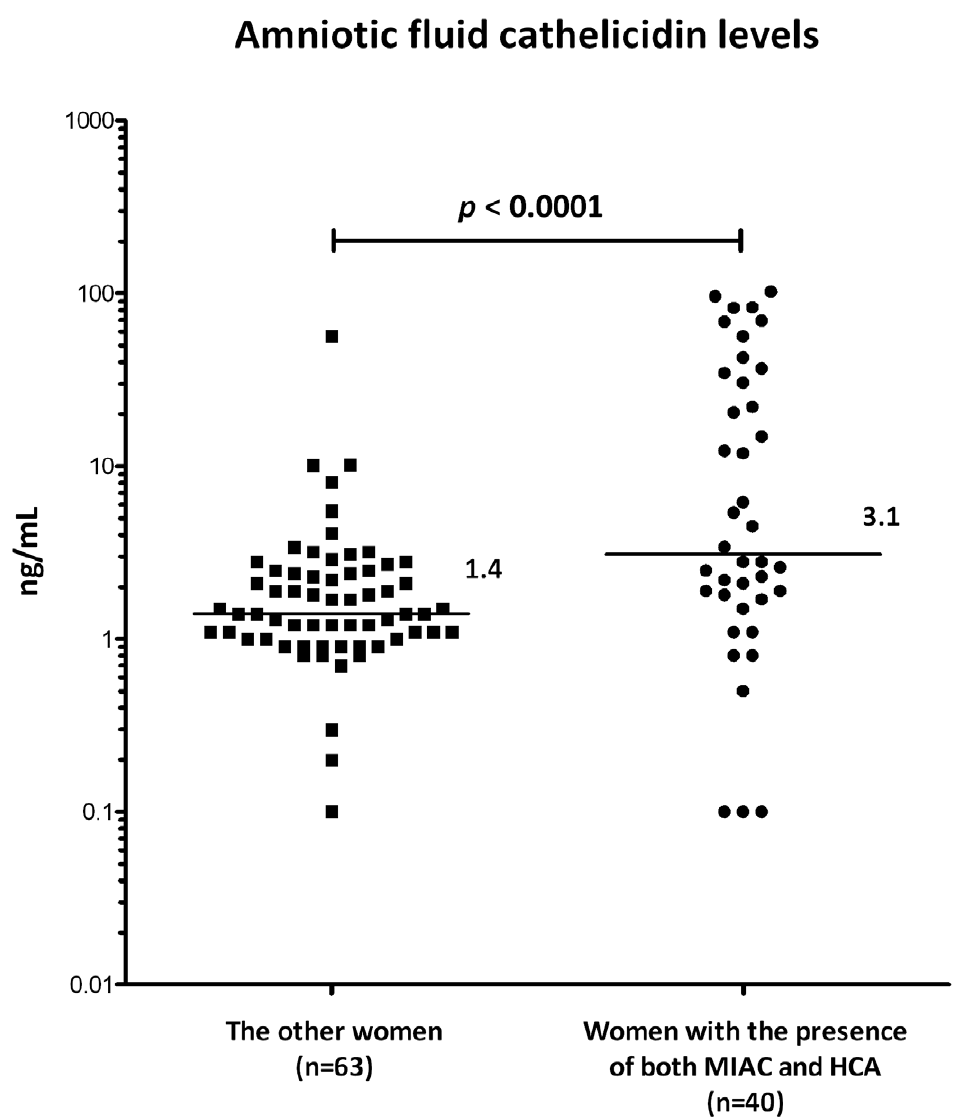
Figure 3. Validation of amniotic fluid cathelicidin levels on independent prospective replication cohort. Amniotic fluid cathelicidin levels in PPROM women with MIAC and HCA were compared with those in whom at least one condition was ruled out. The latter group involved women with neither MIAC nor HCA, without MIAC but with HCA, or with MIAC but without HCA. In line with the validation experiment, amniotic fluid cathelicidin concentrations were significantly higher in women with confirmed MIAC and HCA than in the other women. Cathelicidin levels were measured using a commercial ELISA kit. Values were evaluated using nonparametric Mann-Whitney U test. Graph represents individual values, horizontal bars indicate median values. Abbreviations are explained in the Fig.